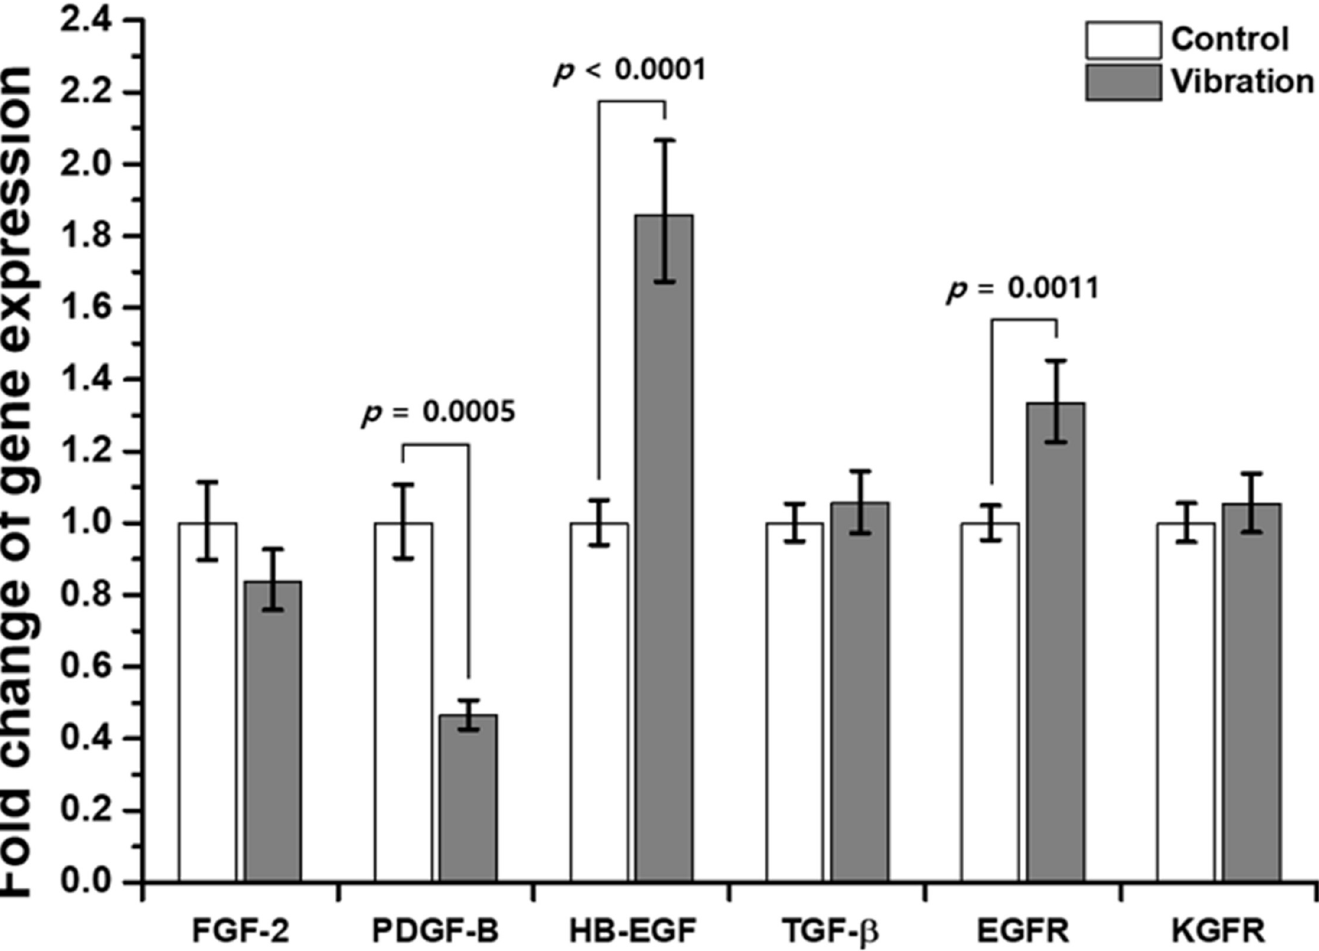
Fig 8. Fold changes in gene expression levels of growth factors and their receptors in HaCaT cells following exposure to mechanical vibration. Fold change was analyzed by using the 2 ( − ΔΔ CT) method, and GAPDH was used as the housekeeping gene ( n = 4).